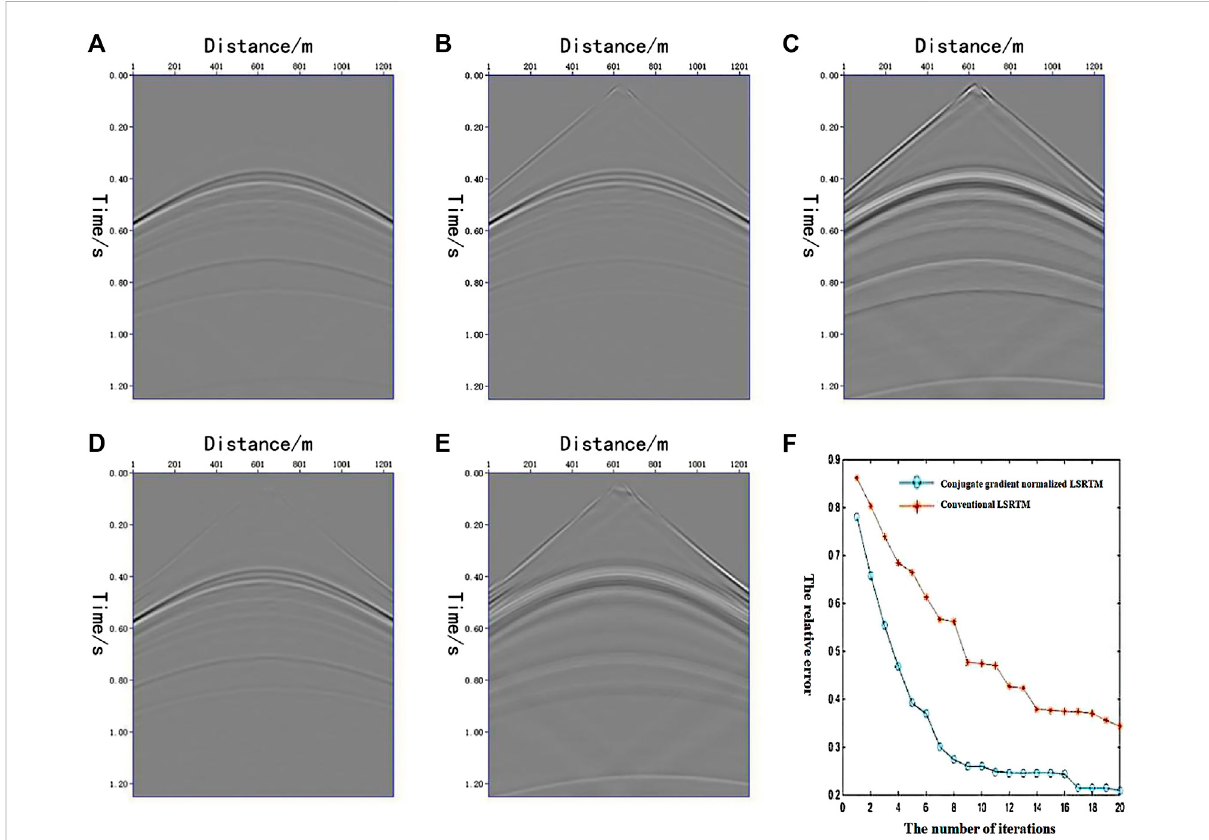
FIGURE 6 Seismic record and error curve of simple model. (A) the 6th observation seismic record; (B) the 6th simulation record of Born approximate forward modeling after 20 iterations by the conventional conjugate gradient cross-correlation LSRTM; (C) the difference between (A,B) ; (D) the